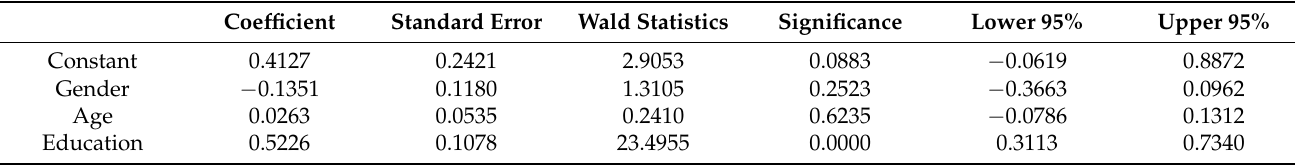
Table 3. Regression Model